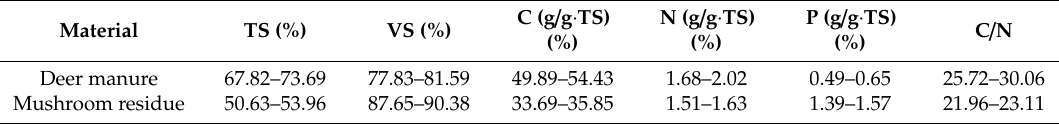
Table 1. Fermentative substrate characteristics. TS: total solid; VS: volatile